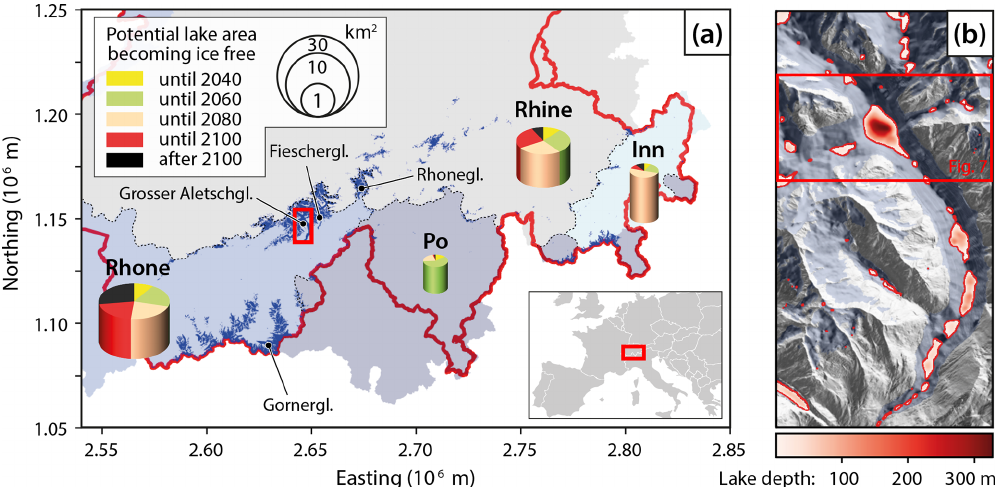
Figure 1. (a) Map of Switzerland (see inset at bottom right for location within Europe) showing the four main river basins (background colours) used for aggregating the results. Glacier extents according to the SGI2016 (Linsbauer et al., 2021) are shown in dark blue. For each catchment, the temporal evolution of the total area of the detected potential glacier lakes is indicated (pie chart area on logarithmic scale; see legend at top left). The results are given in 20-year intervals and correspond to the simulations driven by the median scenario SSP245. Sedimentation is neglected in this graph. The height of the pies indicates the mean depth of the potential lakes within a given catchment. Map coordinates are given in the so-called CH1903 + /LV95 system (official Swiss coordinate system). Glaciers that appear in Table 1 or Fig. 5 are labelled (“gl.” is the abbreviation for “gletscher”). The red box shows the area enlarged in panel (b) . (b) Map of the lower part of Grosser Aletschgletscher, illustrating the morphology of potential glacier lakes. Lakes are contoured in red, with depths given by the reddish colours. The SGI 2016 glacier extent (blueish background) is given together with a shaded relief of the swissALTI3D surface DEM and the subglacial topography (grey shading). The red box indicates the area shown in Fig. 7. Table 1. Overview of the five largest potential lakes. The lake volume expected to be ice free until 2050 and 2100 (neglecting sedimen- tation) is given for SSP245 and is expressed in percentage of the potential total lake volume. Square brackets provide confidence intervals for the given quantities (see Sect. 3.3). Note that two of the five potential lakes are predicted for the area presently occupied by Grosser Aletschgletscher. Glacier Lake ID Area Elevation Potential volume Volume free Volume